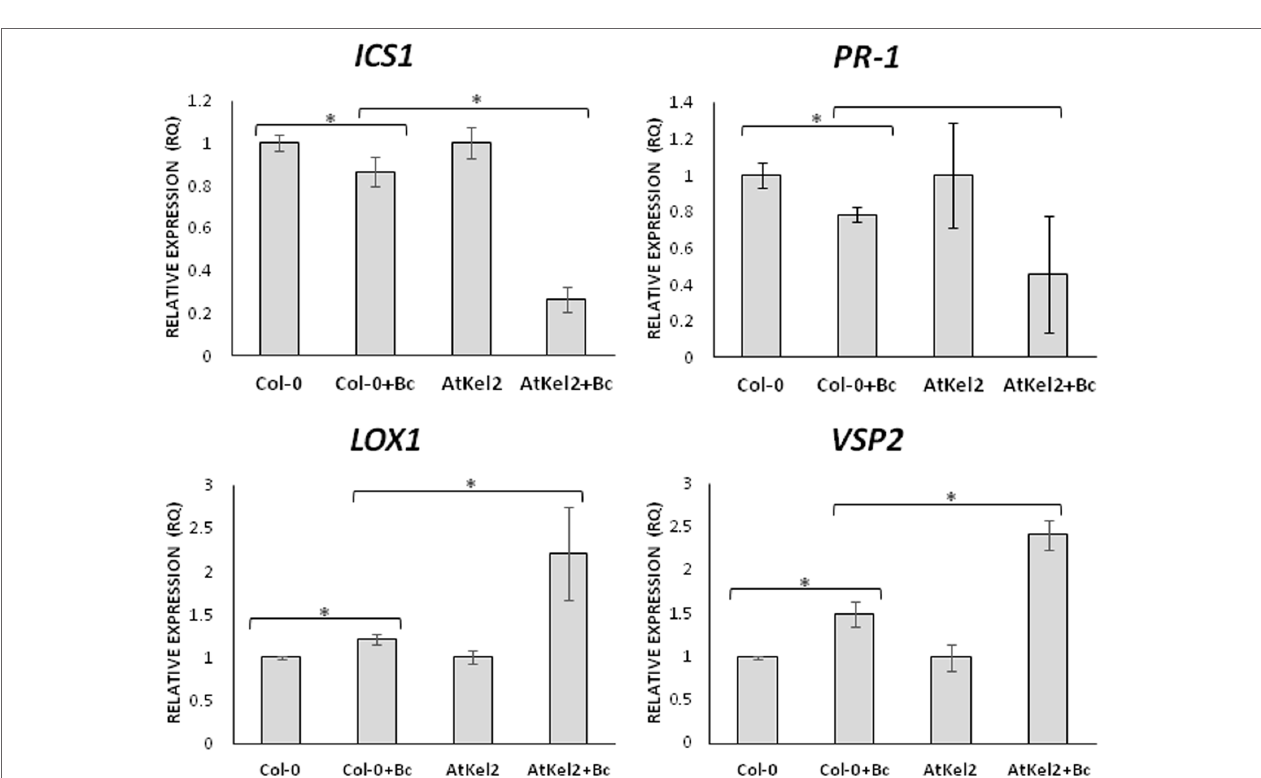
FIgURE 4 | Quantitative reverse transcription polymerase chain reaction (RT-qPCR) analysis of the expression of some defense genes in the leaves of A. thaliana wild type (Col-0) and the transgenic line AtKel2 infected with B. cinerea , 120 h after infection (+Bc). Genes of the isochorismate synthase 1 ( ICS1 ), pathogenesis-related protein 1 ( PR- 1 ), lipoxygenase 1 ( LOX1 ) and vegetative storage protein ( VSP2 ). Values correspond to relative measurements against plants without infection (2 –ΔΔCt = 1). The Arabidopsis actin gene was used as an internal reference gene. Data are the mean of three biological replicates for each condition with the corresponding standard deviation, and for each biological replicate and condition, three leaves per plant from five plants were used. Student’s t-test was performed. Asterisks denote significant differences at P ≤ 0.05.